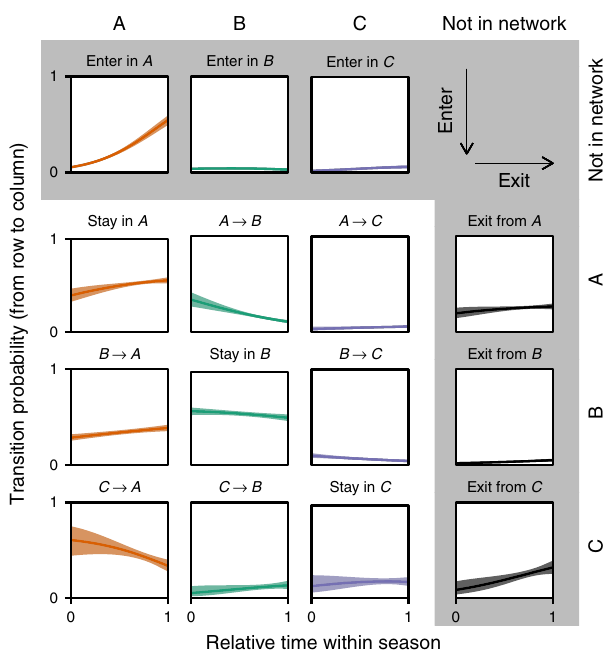
Fig. 4 Movement of pollinator species across position groups. Every panel in the matrix describes the inferred transition probability between the different groups of positions as a function of the relative time within the season. The order of the matrix is such that it characterizes the transition probabilities from row groups to column groups over time. The different groups are those presented in Fig. 3. The shaded row describes the probabilities of species entering the network into the different groups ( A , B and C ) whereas the shaded column describes the probabilities of species exiting the network from each of these groups. The different lines in the graph represent the mean transition probabilities and the shade of each line characterizes the fi rst and third quantiles. Notice that the color is chosen based on the recipient group of the transition